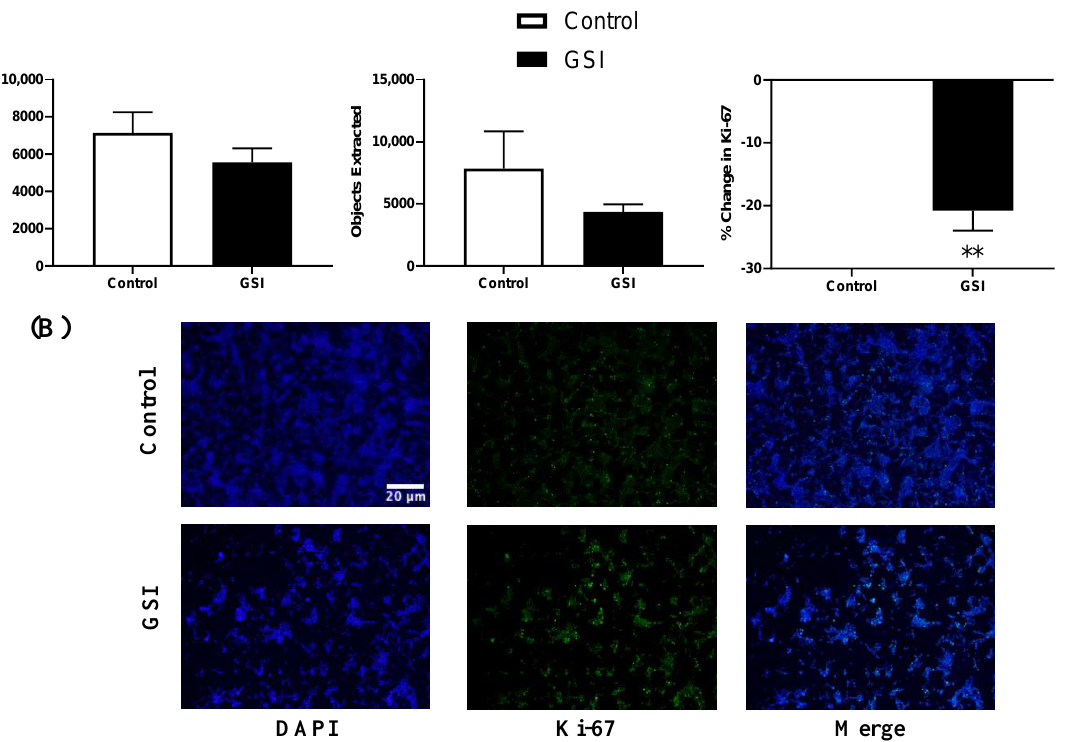
Figure 7. Ki-67 immunofluorescence in Lewis lung carcinoma cells treated with GSI. ( A ) Total objects and objects extracted using binary feature extractor via Fiji. Percent change in Ki-67 expression relative to control in 48 h LL/2 cells treated with or without 4 µM Ɣ -secretase inhibitor (GSI) every 12 h. ** p < 0.01 vs. control (n = 5). ( B ) Representative immunofluorescence images of LL/2 cells treated with or without 10 mM metformin using 4’,6-diamidino-2-phenylindole (DAPI) and Ki-67 expression visualized via AlexaFluor 488. Representative images were taken at 10x. Scale bar = 20 µm.